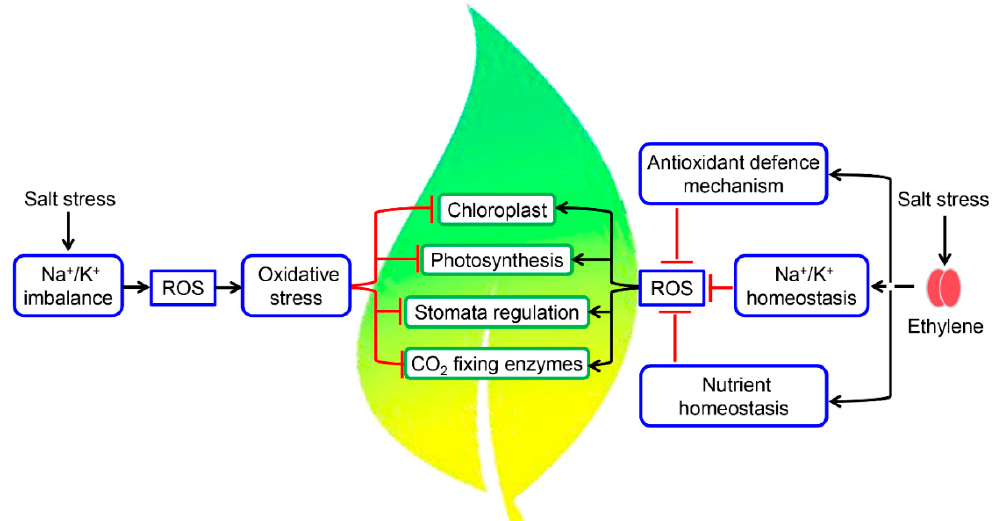
Figure 2. Functions of ethylene in the regulation of photosynthesis under salinity stress. In the absence of ethylene, salinity stress results in an imbalance of Na + /K + homeostasis, which leads to the production of ROS. This salinity-induced ROS production, in turn, exerts oxidative stress on plants, resulting in stomatal closure and reduced activity of CO 2 -fixing enzymes, resulting in a decrease in photosynthesis. In the presence of ethylene, Na + /K + homeostasis and nutrients homeostasis are maintained, and the antioxidant defense mechanism is activated, which limits ROS production, thereby preventing ROS-induced oxidative stress. In the absence of oxidative stress, the rate of photosynthesis is maintained even during salinity stress.